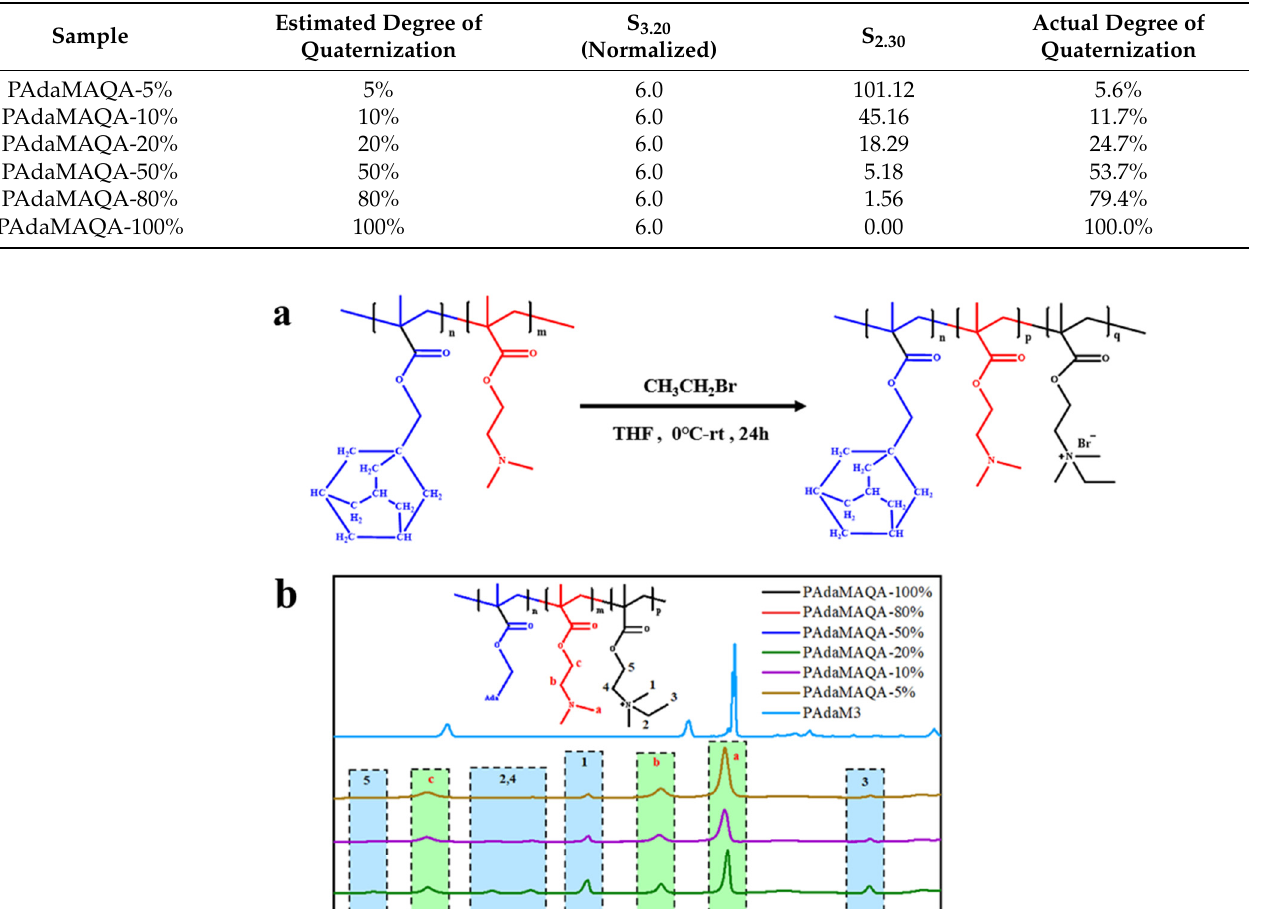
Table 2. The degree of quaternization of PAdaM3QA − X.